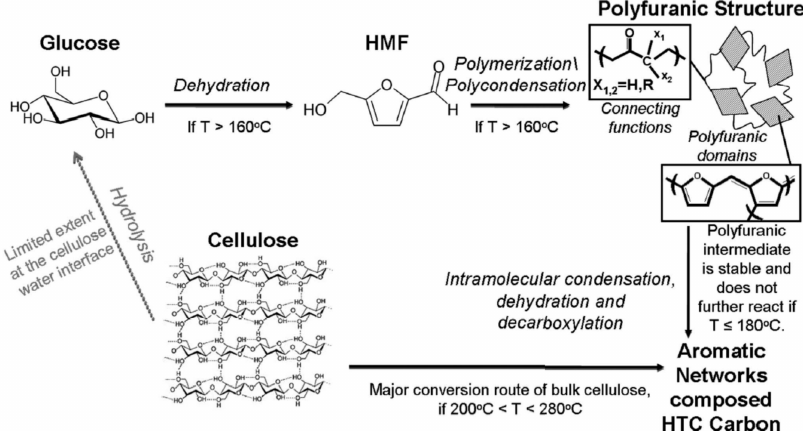
Figure 6. Different hydrothermal carbonization mechanisms for glucose and cellulose under mild processing conditions (180 ◦ C < T < 280 ◦ C). Reprinted with permission from Reference [70]. Copyright (2011) Royal Society of